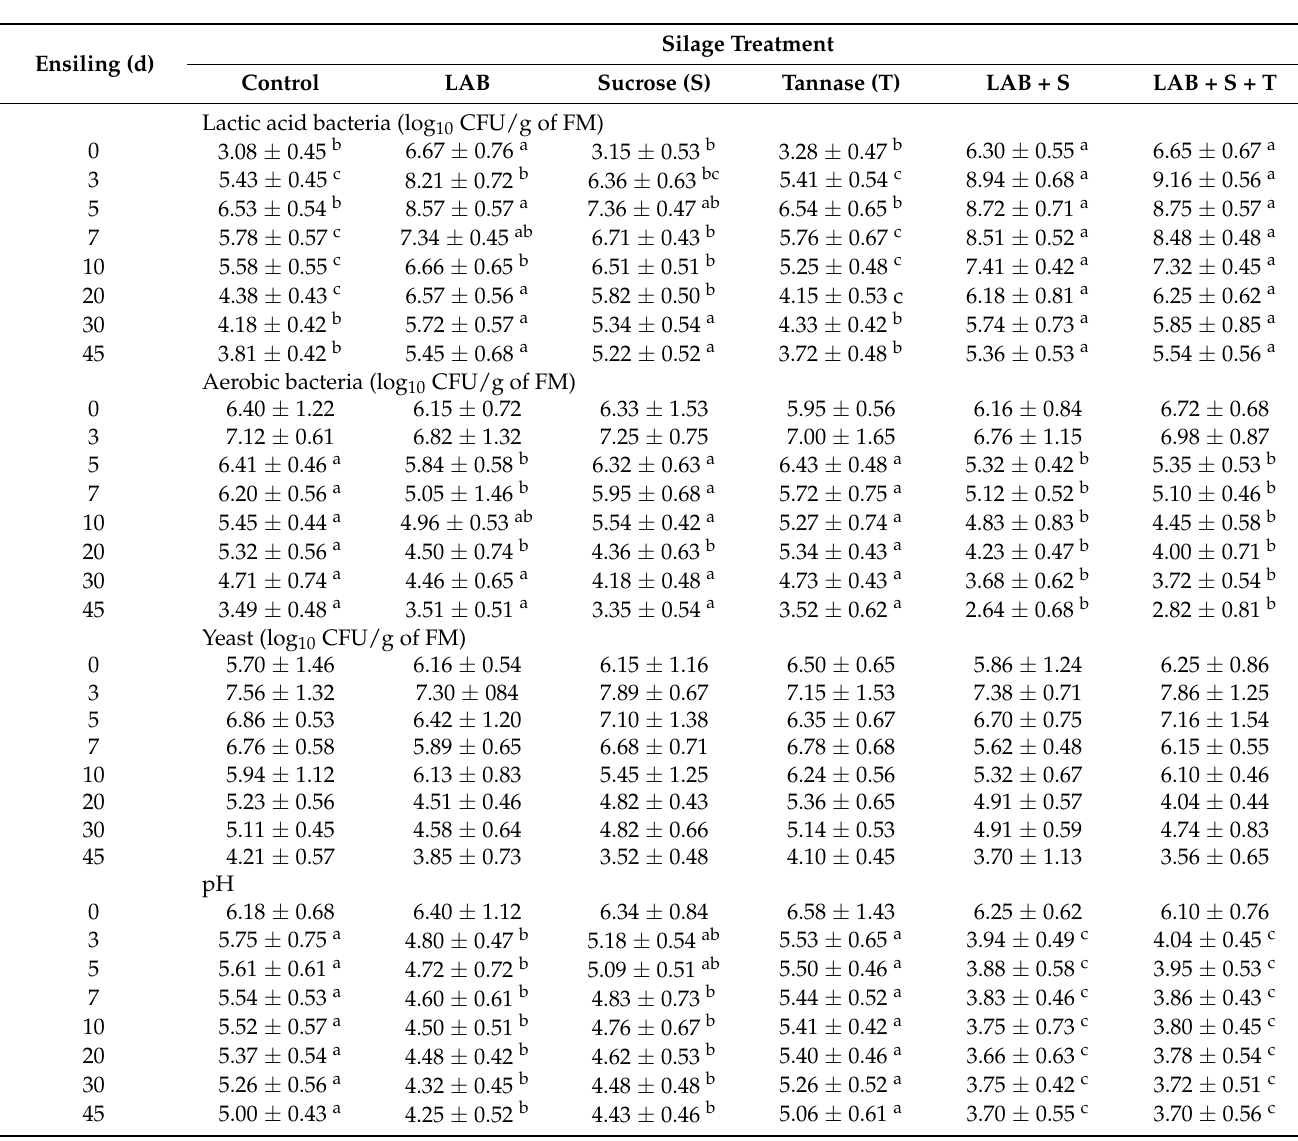
Table 3. Microbial population and pH value of the defective bananas during ensiling